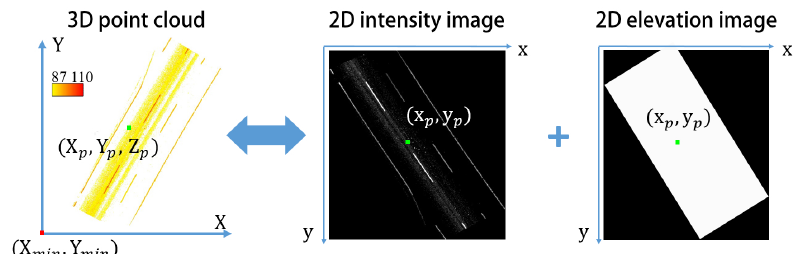
Figure 9. The correspondence between the 3D point cloud and the 2D images. On the left is a top view of the 3D point cloud, whose origin is at the lower-left corner. On the right are the generated 2D intensity and elevation images, whose origins are at the upper-left corner. The gray values of the pixel ( x p , y p ) in the 2D intensity and elevation images are equal to the intensity and elevation of the 3D point ( X p , Y p , Z P ) , respectively.